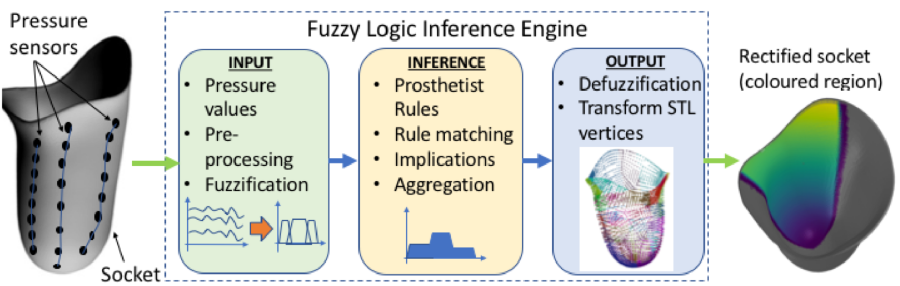
Figure 2. Main blocks of the DSS